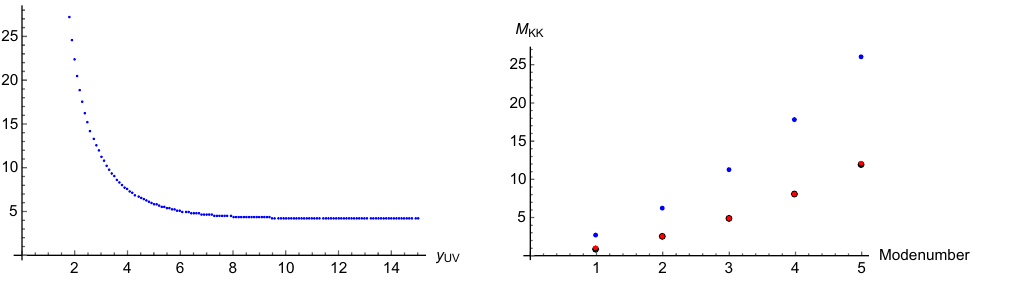
Figure 9 . Left: the (cid:12)rst eigenvalue of the numerical solution for di(cid:11)erent y UV . Right: eigenvalues of the numerical solution (blue) and analytical approximation (red) of the (cid:12)rst (cid:12)ve radial modes. The numerical evaluation of the spherical Bessel equation is shown in